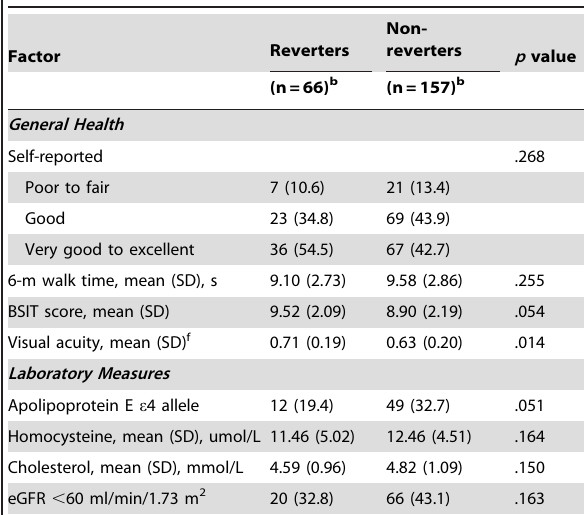
Table 1. Sociodemographic, lifestyle and health characteristics of reverters and non-reverters at baseline a